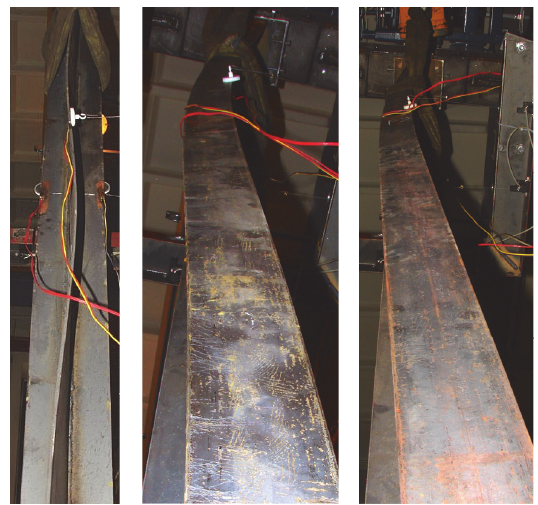
Figure 7: Local buckling of column D2 (before collapse occurred) and torsional-flexural buckling of columns E3 and F3 (after col- lapse).